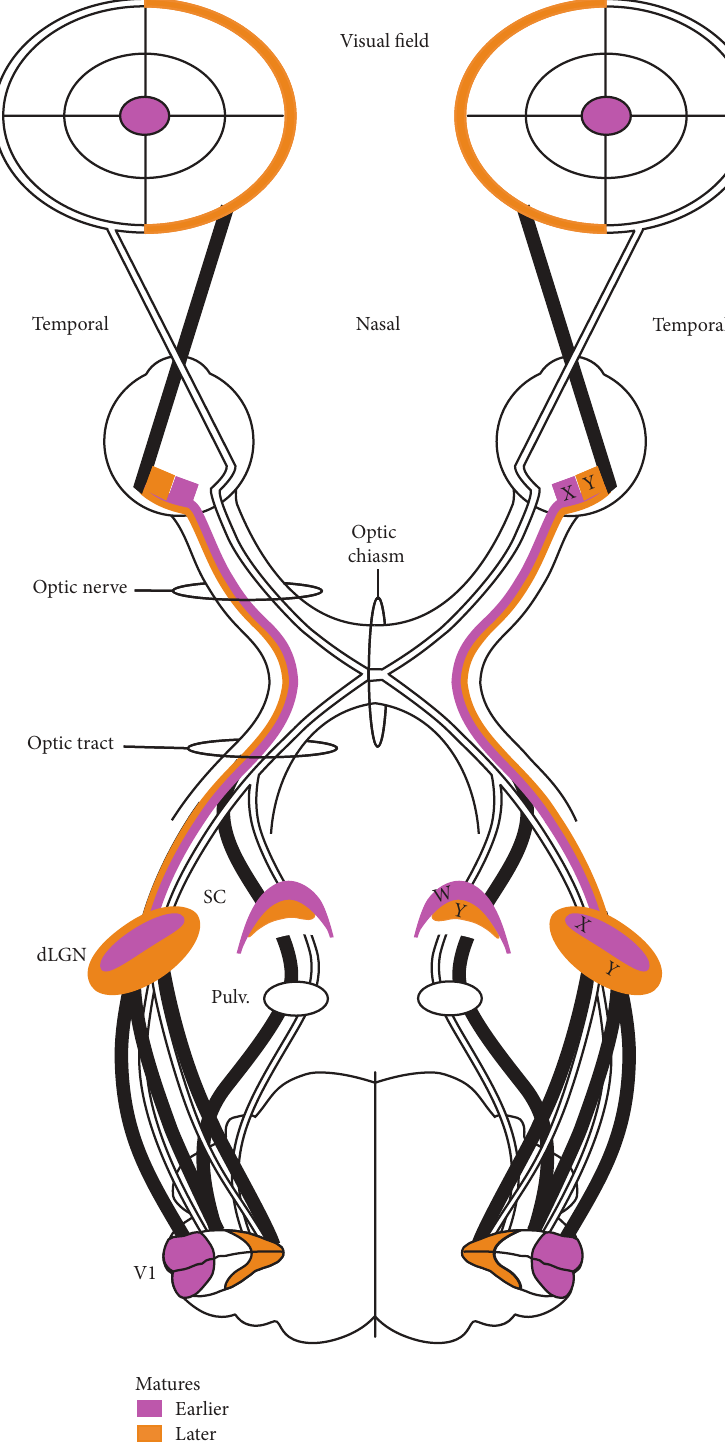
Figure 4: The main projection pathways of the carnivore shown as a compilation of developmental data. Parts of the scheme that are marked in pink develop earlier than those marked in orange. First visually evoked responses derive from central visual field (cats: [57]; humans: [58]); peripheral locations within nasal visual hemifield evoke responses later (humans: [57]; cats: [96]). Central-to-peripheral developmental gradientisshownintheretina(multispeciesreview[49])andatthecorticallevel(marmosets:[54];cats:[55]).X-typecellsdevelopearlierthan Y-type in the retina [123] and at the dorsal lateral geniculate nucleus (dLGN) level (humans: [124]; cats: rev. [125]). W-type cells develop earlier than Y-type at the superior colliculi (SC) level [126]. Superior colliculus develops earlier than dorsal lateral geniculate [127, 128]. Ipsilateral projections from peripheral retina develop later (cats: